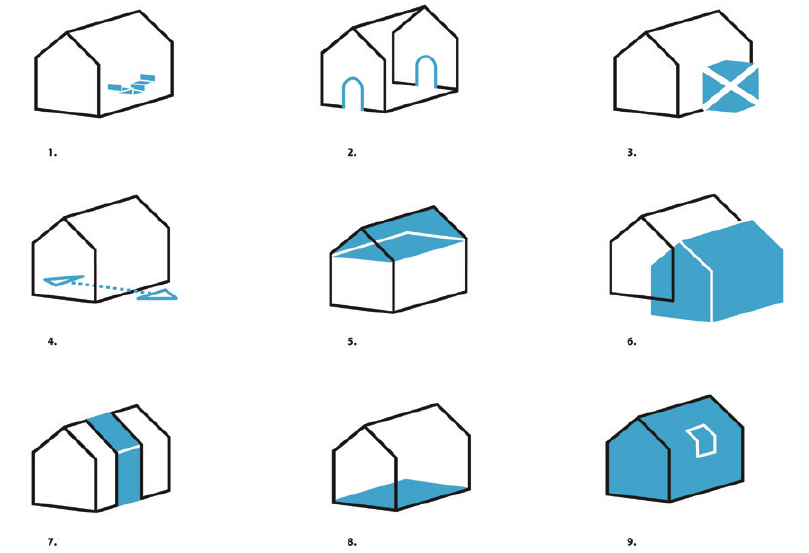
Figure 1. Icons of the nine conversion strategies: 1) “Precise interventions”, 2) “Break open”, 3) “Restore original qualities”, 4) “Continue route”, 5) “Use of surplus space”, 6) “Old and new”, 7) “Put together”, 8) “Adaptive reuse”,